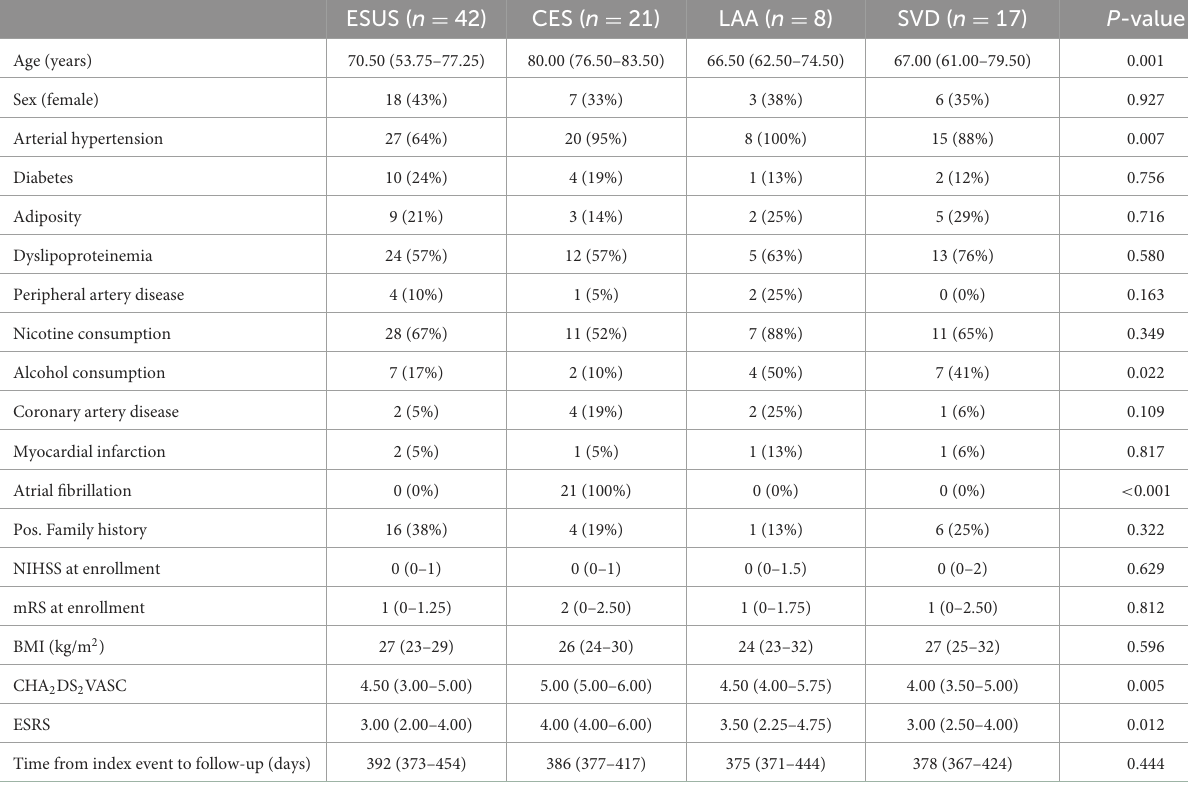
TABLE 1 Clinical and demographical data of cohort